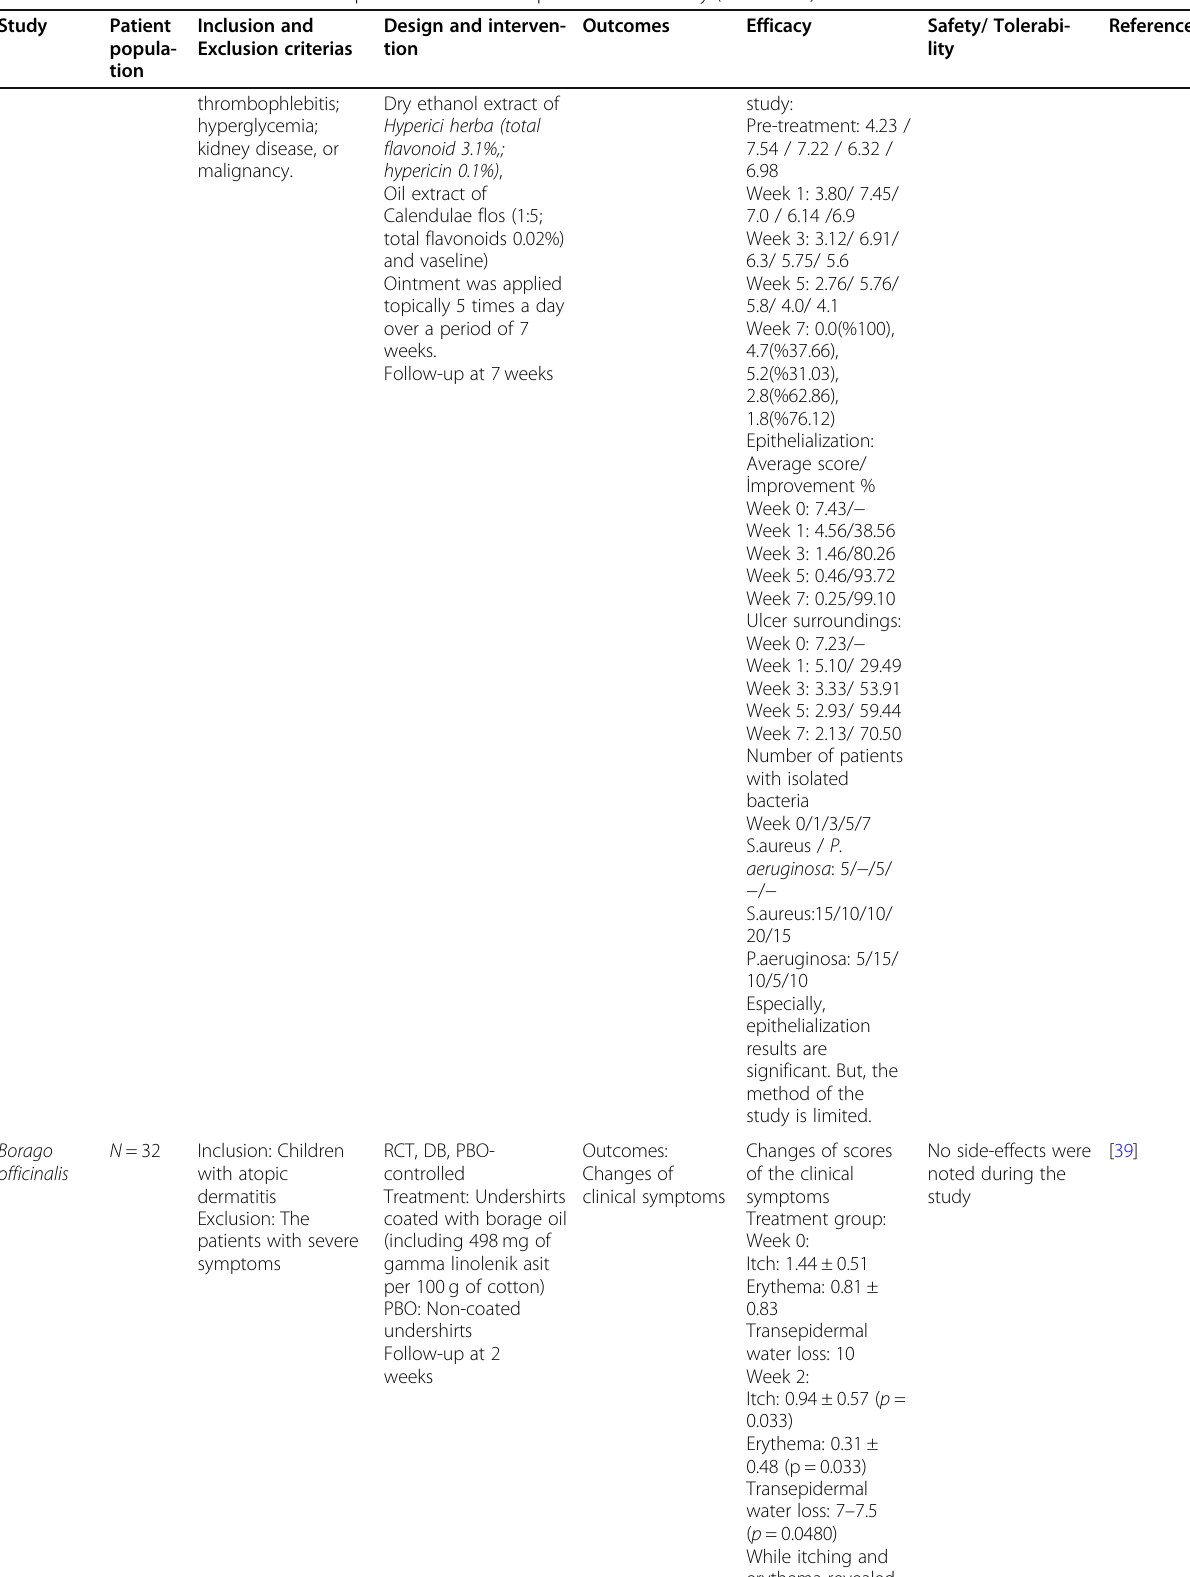
Table 4 Clinical trials of the traditional plants used for skin problems in Turkey (Continued) Study Patient